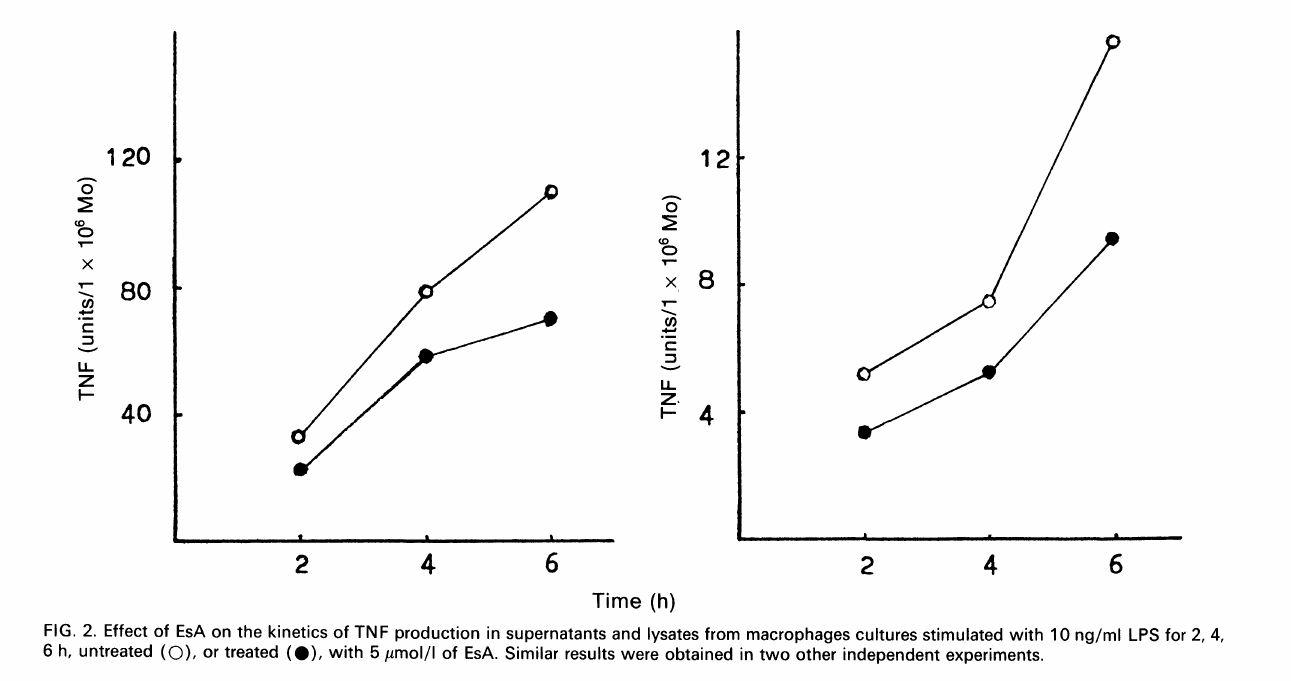
FIG. 2. Effect of EsA on the kinetics of TNF production in supernatants and lysates from macrophages cultures stimulated with 10 ng/ml LPS for 2, 4, 6 h, untreated ((C)), or treated (O), with 5 #mol/I of EsA. Similar results were obtained in two other independent experiments. 376 Mediators of Inflammation. Vol